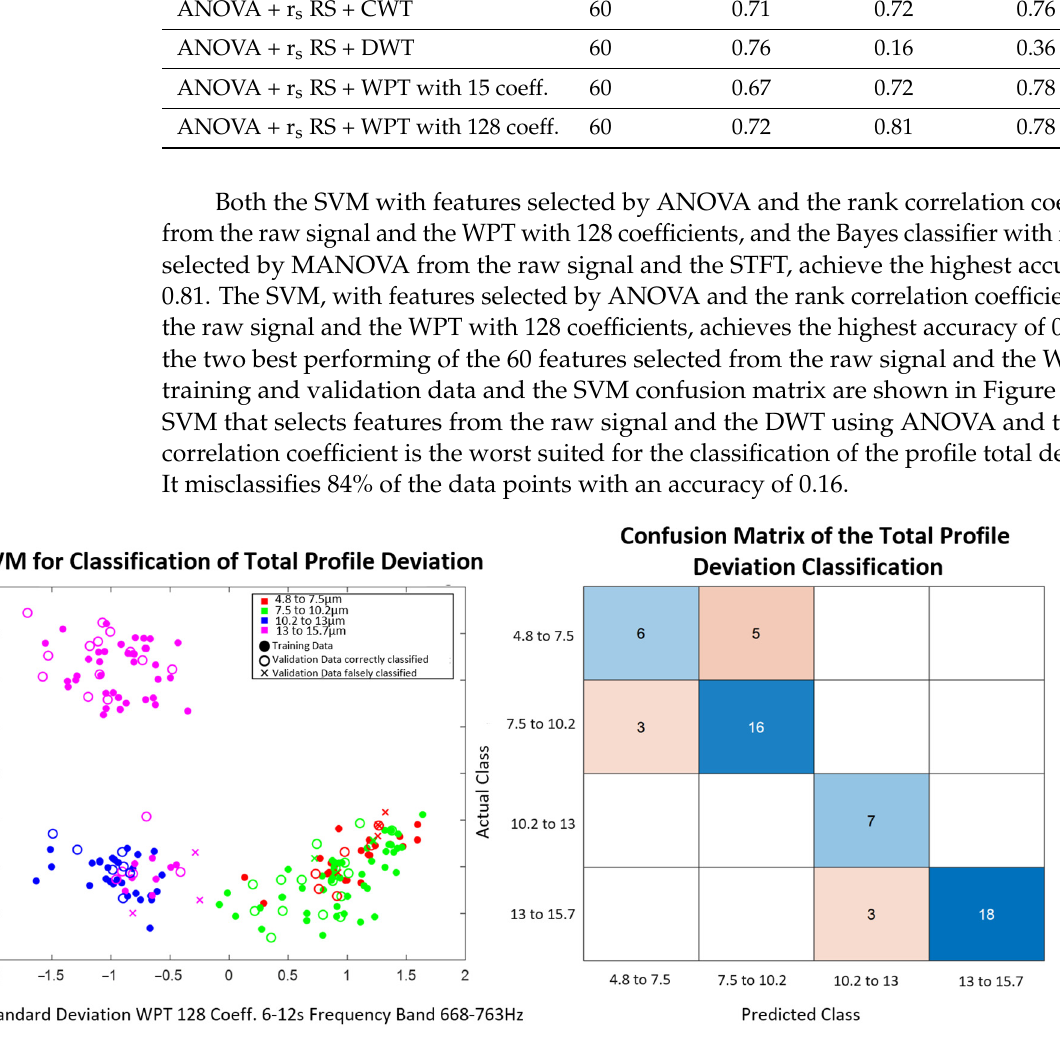
Figure 14. Best two features and confusion matrix of SVM for classification of profile total deviation (feature selection: ANOVA+rs, features from raw signal and WPT with 128 coefficients).